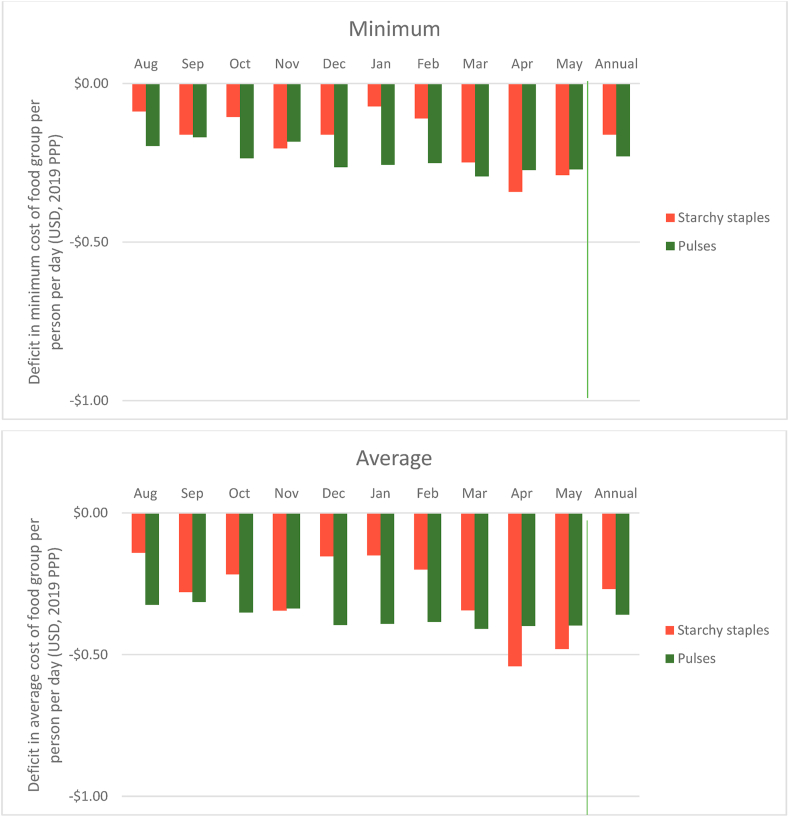
Seasonal trend in actual vs recommended cost of staples.